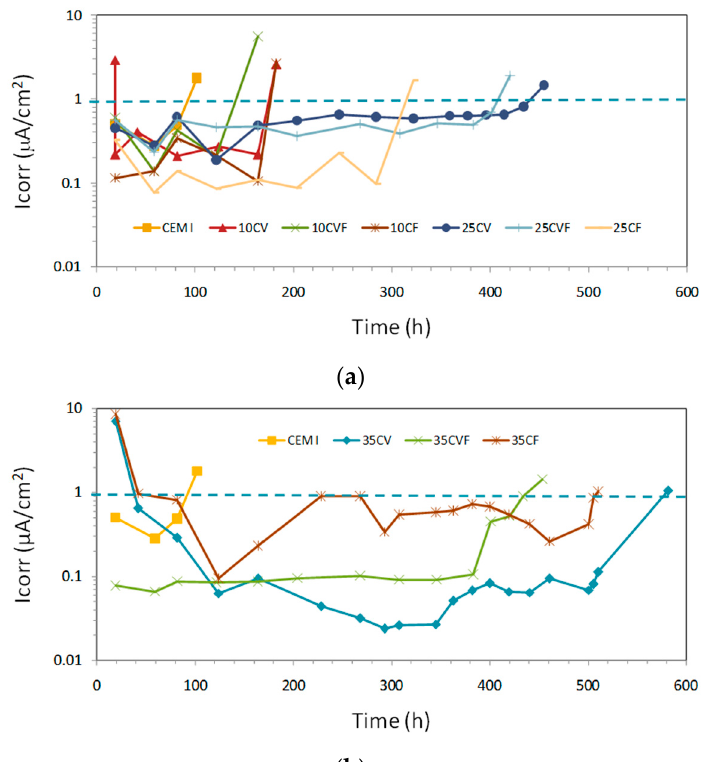
Figure 7. I corr vs. time. The different lines per plot represent the samples per mix: (a) samples CEM I, 10CV, 10CVF, 10CF, 25CV, 25CVF, 25CF; (b) samples CEM I, 35CV, 35CVF, 35CF. The dashed line indicates the I corr value for corrosion initiation (I corr = 1 μ A/cm 2 ).